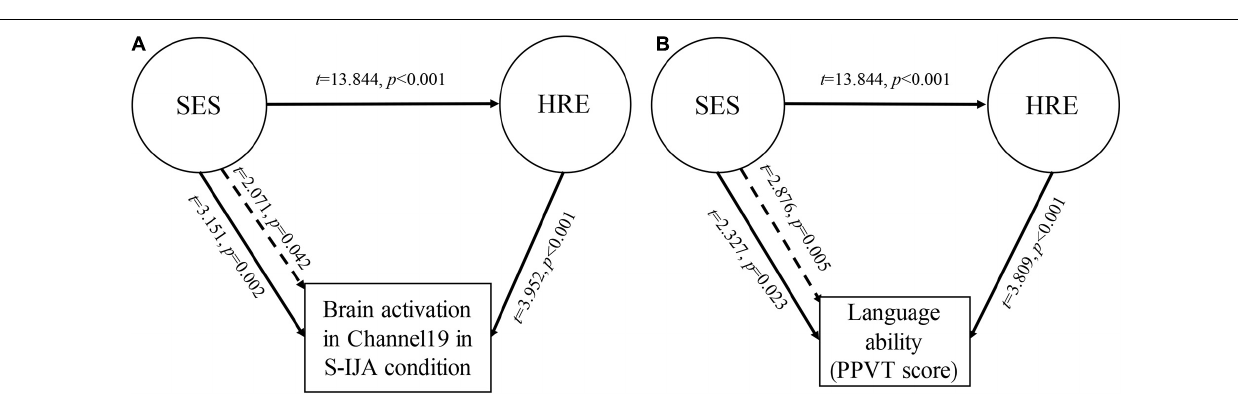
FIGURE 5 | Schematic of mediation models. (A) The mediating effect of HRE on the association between SES and brain activation in Channel 19 during initiating joint attention. (B) The mediating effect of HRE on the association between SES and language (PPVT score). SES, socioeconomic status; HRE, home reading environment; PPVT, Peabody Picture Vocabulary